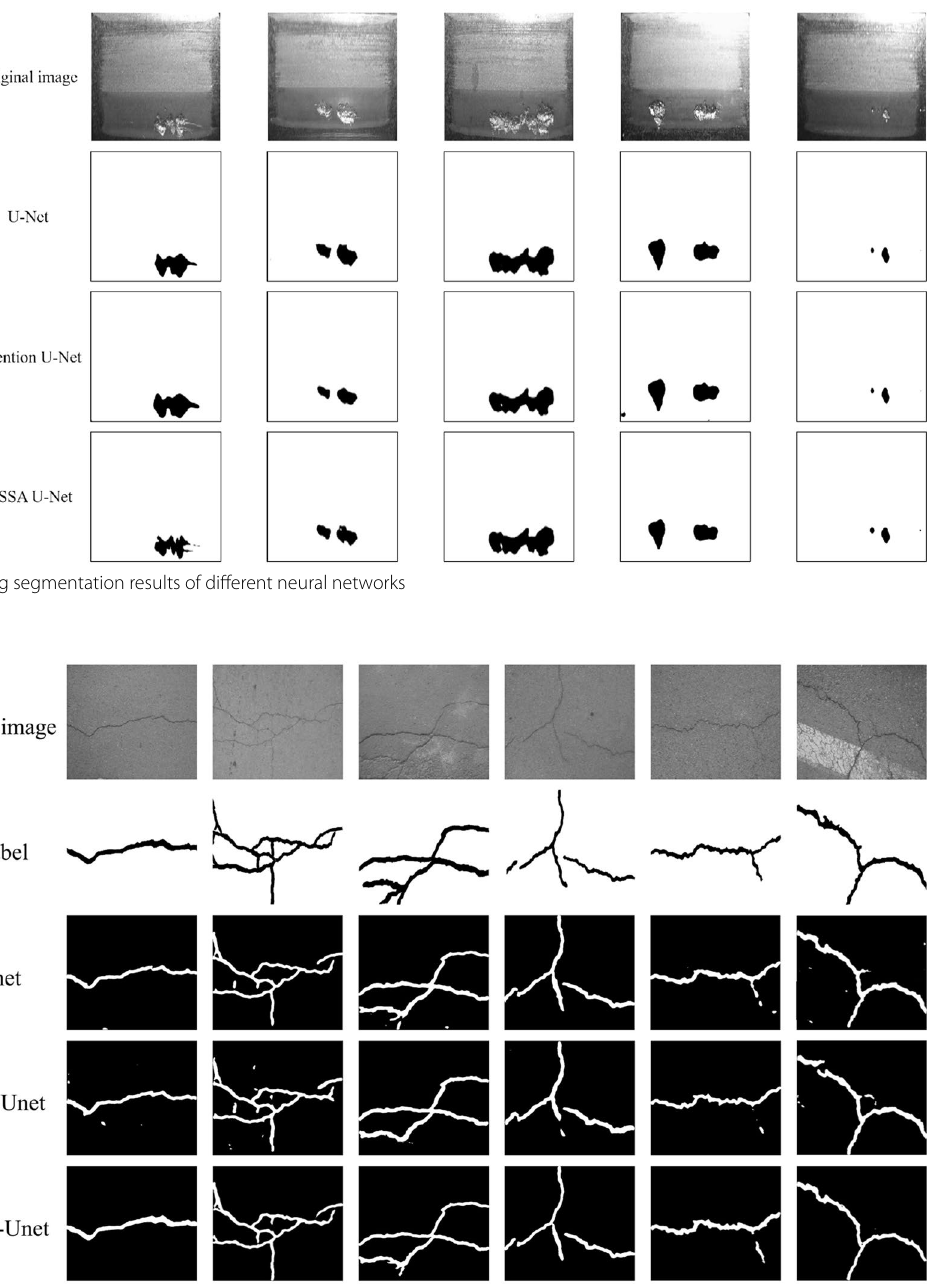
Figure 14 Typical segmentation results of the “Crackforest” dataset obtained by various neural